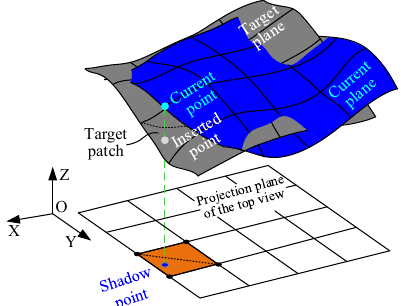
Figure 15. Principle of computing the distances between the corresponding points by projecting [26].